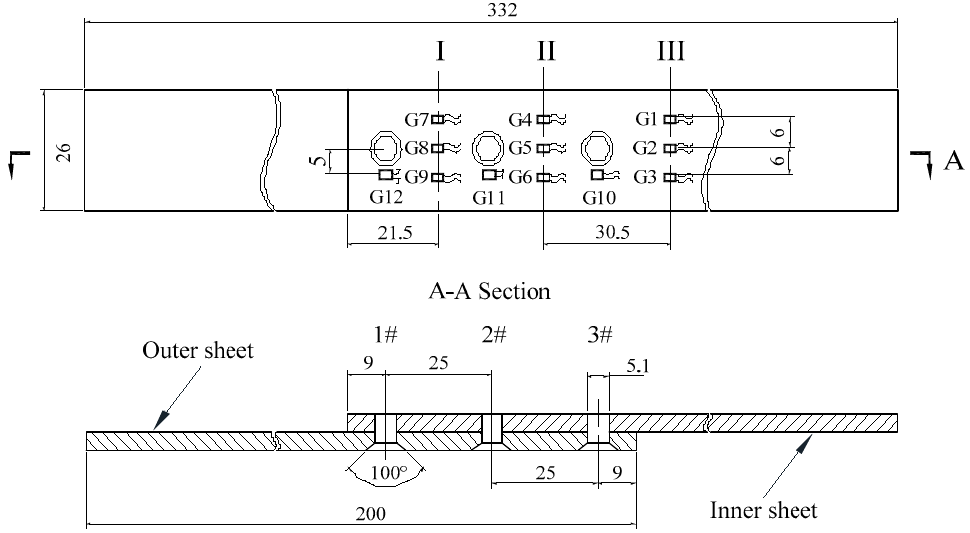
Figure 5. Overall configuration of the specimen (Unit: mm).